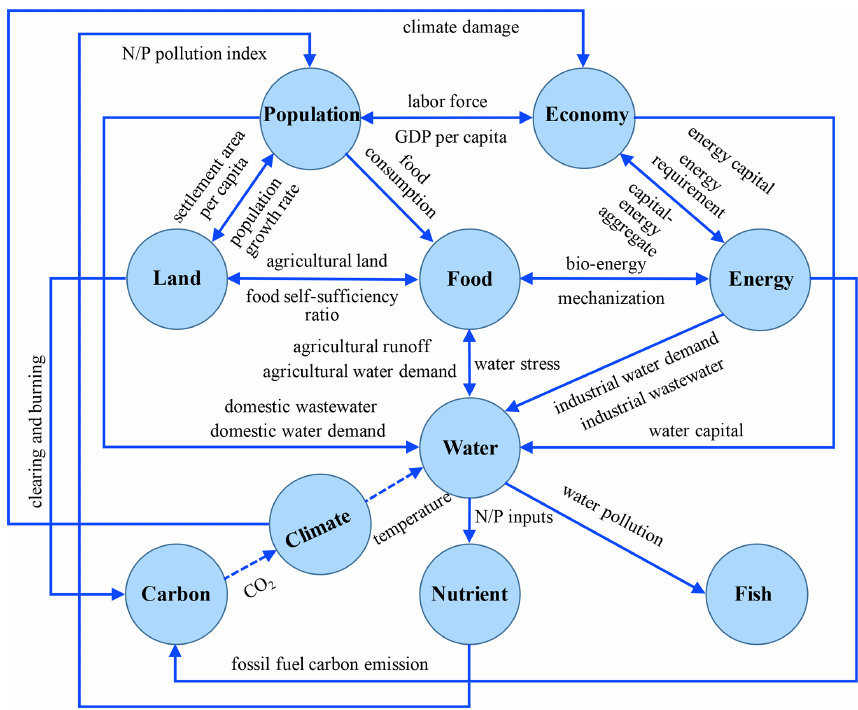
Figure 2. Cross-sectoral interactions among the human–natural systems in the